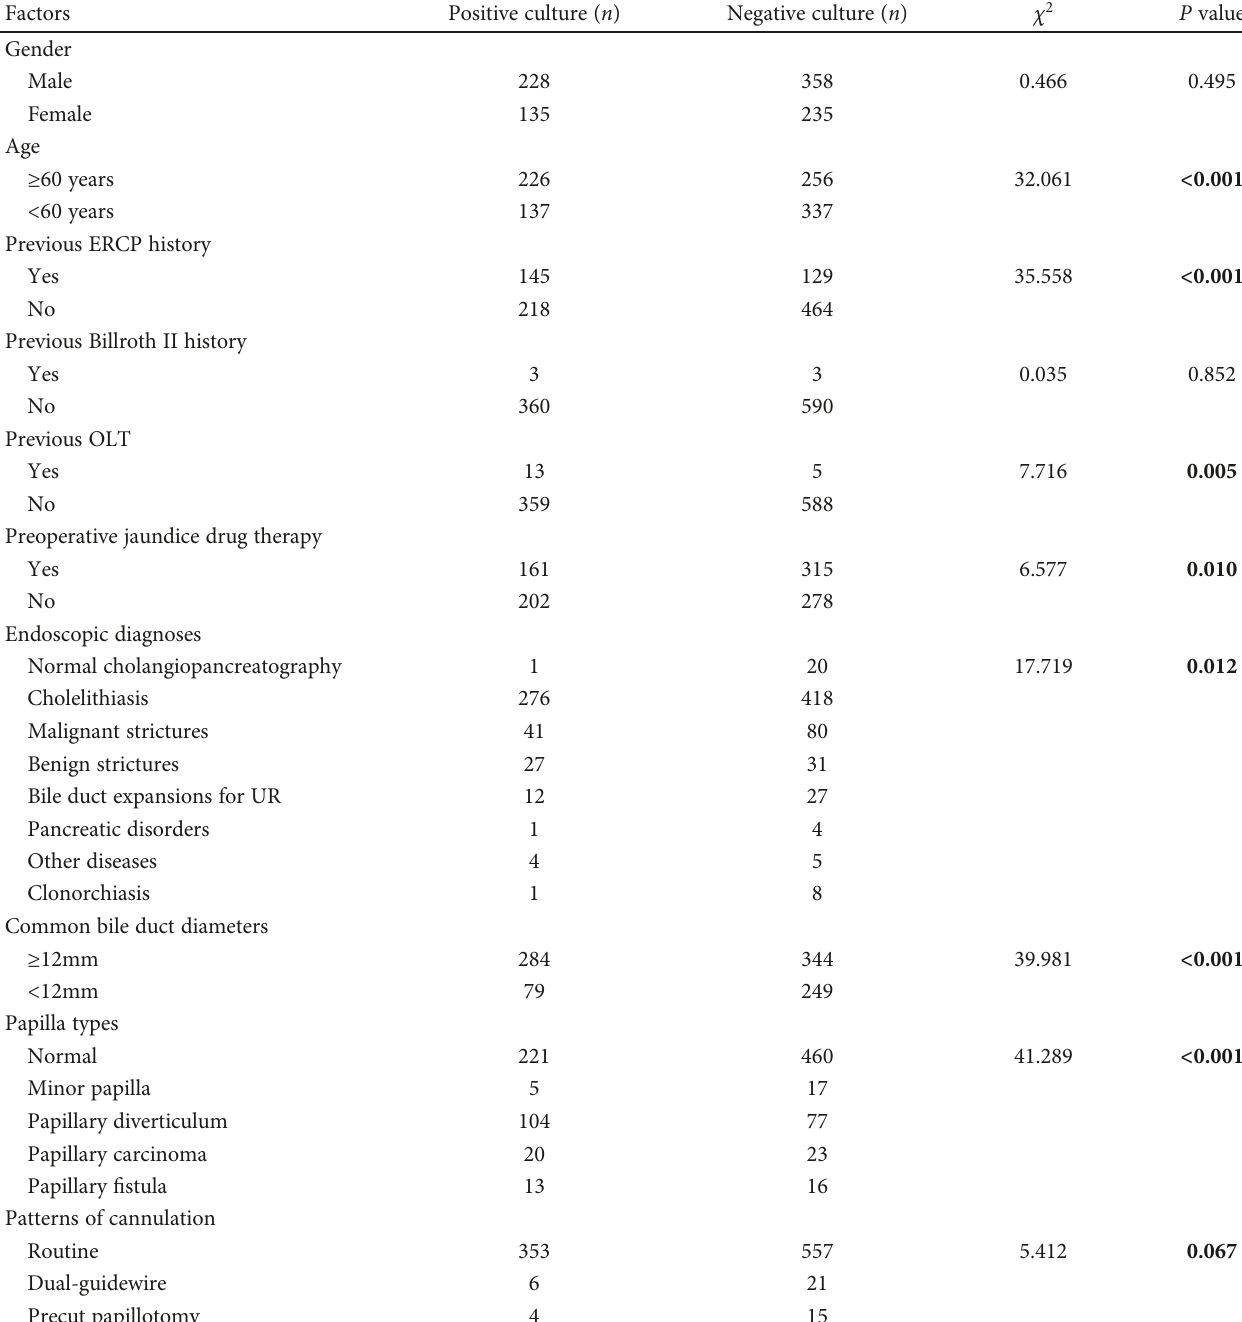
Table 4: Univariate analysis of risk factors for bile